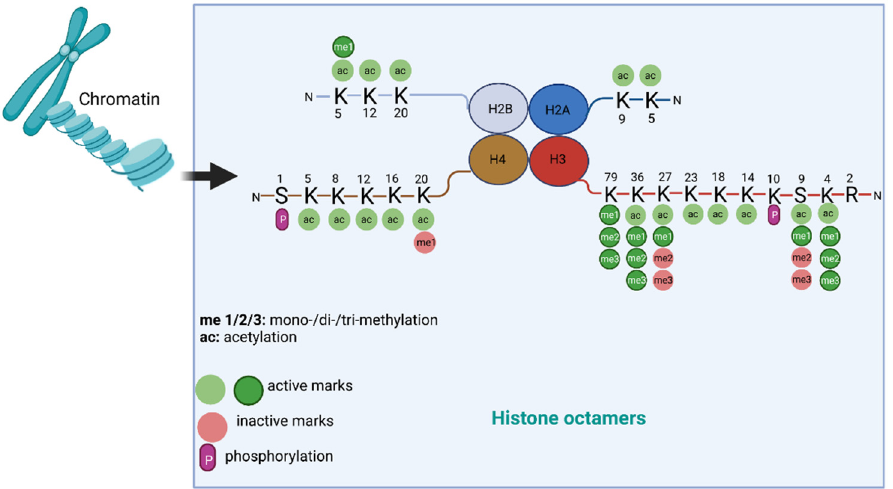
Figure 2. Common histone modifications and their functions.